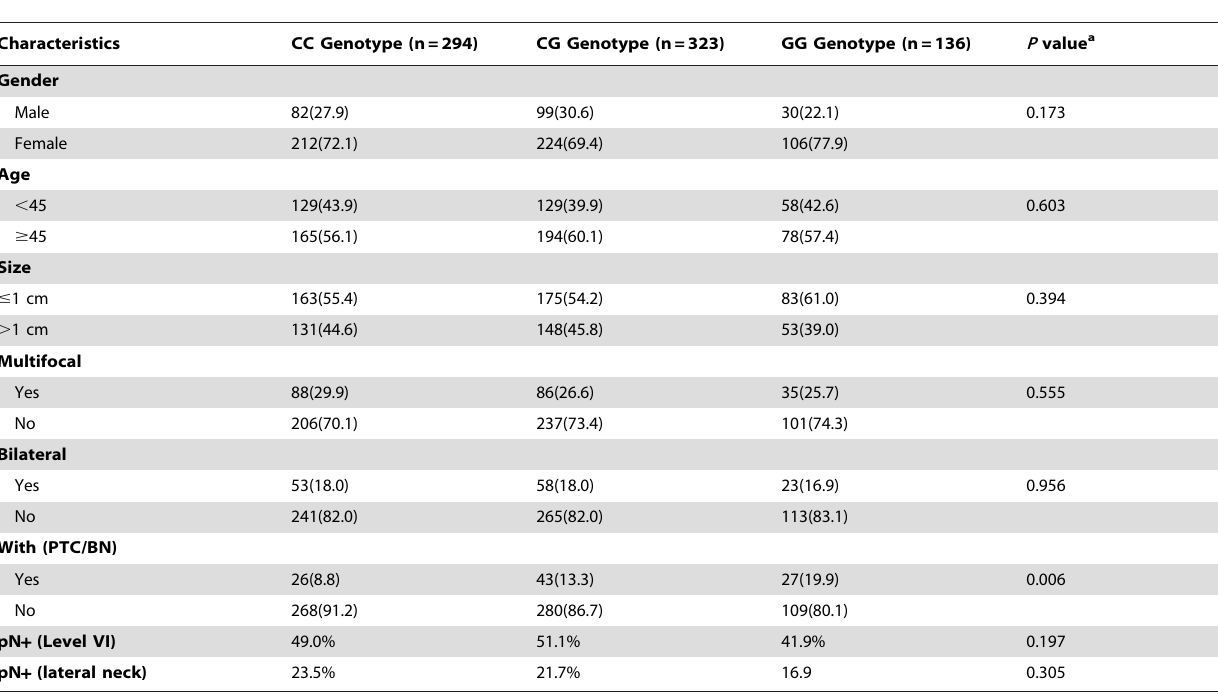
Table 3. The clinical characteristics of PTC with different rs2910164